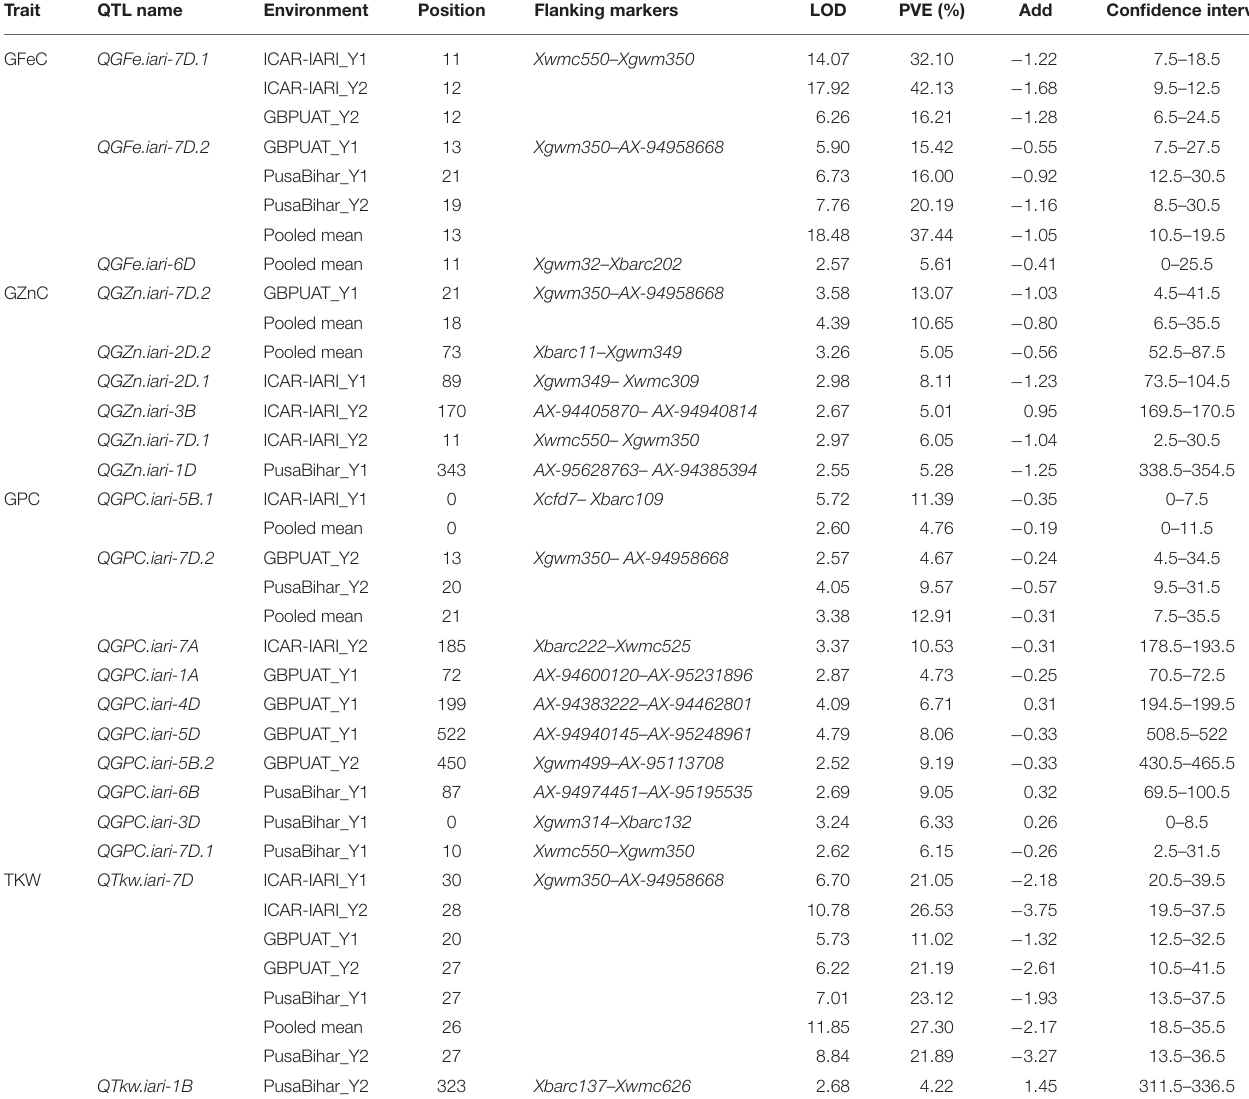
TABLE 4 | QTL identified for grain iron, zinc, protein, and thousand kernel weight in RIL population grown across three locations for 2 years.